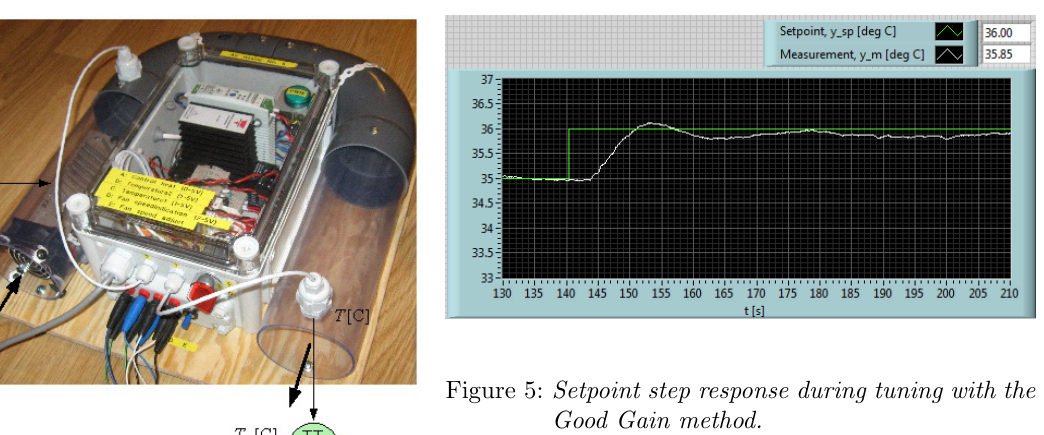
Figure 5: Setpoint step response during tuning with the Good Gain